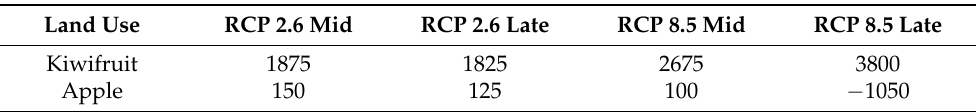
Table 1. Projected land-use change (hectares) for kiwifruit and apples from the multinomial logit by climate pathway, relative to baseline land-use areas.